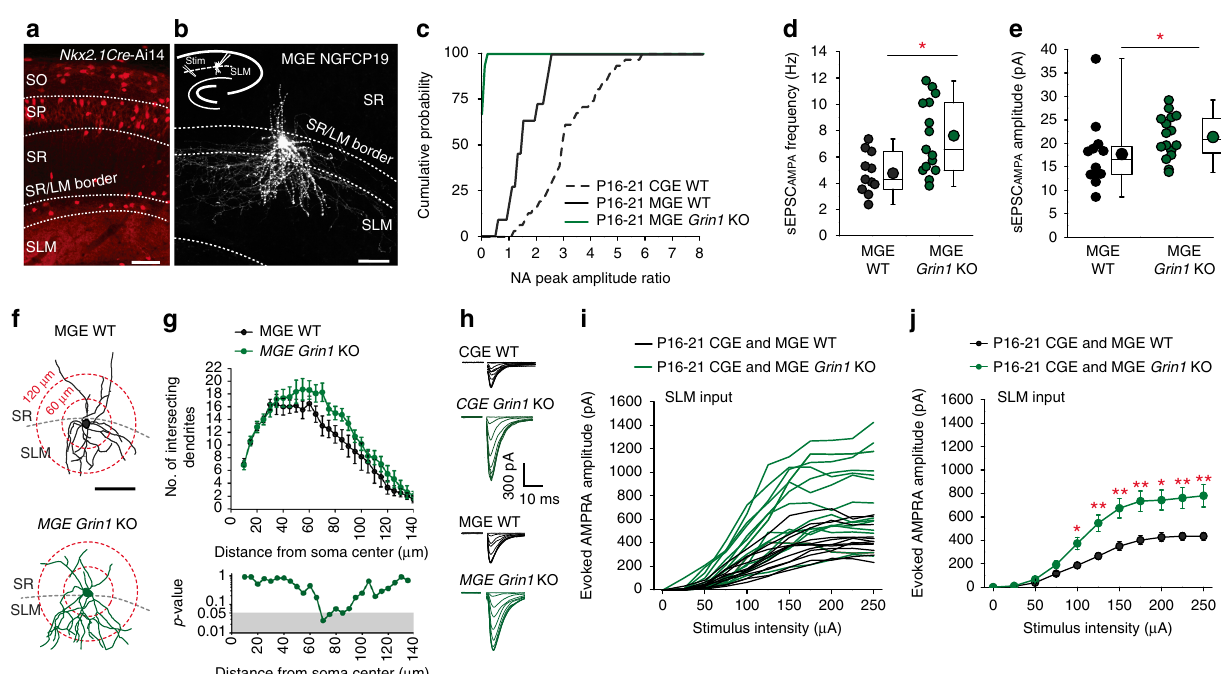
Fig. 5 NMDA-hypofunction precipitates similar morpho-physiological abnormalities in MGE NGFCs resulting in increased synaptic strength of SLM excitatory drive regardless of embryonic origin. a Confocal image of Nkx2.1Cre:Ai14 mouse illustrating the lamina distribution of MGE-derived interneurons. Scale bar , 100 μ m. b Confocal image of a biocytin- fi lled TdTom-positive NGFC illustrating the polarized dendrites in SLM and SR. Scale bar , 50 μ m. Inset depicting recording and stimulus (stim) electrode arrangement. c Cumulative distribution of NA peak amplitude ratios in P16-21 MGE WT ( black line ; n = 12) and MGE Grin 1 KO ( green line ; n = 16) mice. Black dotted line denotes NA ratio distribution in CGE WT NGFCs at P16-21 and is re-plotted from Fig. 1k for comparative purposes. d sEPSC AMPA frequency in MGE NGFCs in P16-21 WT ( black circles ; n = 11) and Grin1 KO mice ( green circles ; n = 16). e sEPSC AMPA amplitude in MGE NGFCs in P16-21 WT ( black circles ; n = 11) and Grin1 KO mice ( green circles ; n = 16). f Dendritic arborization of MGE NGFCs from WT ( black cell ; top panel ) and Grin1 KO ( green cell ; bottom panel ) mice. Examples of concentric circles employed for Sholl analyses ( red circles ). Scale bar , 100 μ m. g Sholl analyses plots of NGFC dendrites from WT ( black data ; n = 6) and Grin1 KO mice ( green data ; n = 12). Bottom panel show statistical comparison with shaded gray areas denoting p < 0.05. h Single overlaid traces of SLM afferent evoked AMPAR-mediated EPSCs in CGE and MGE NGFCS from P16-21 WT ( black traces ) and Grin1 KO ( green traces ) mice at varying stimulus strengths (0 – 250 μ A in 25 μ A steps). i , j Individual and pooled relationship of SLM- evoked AMPAR-mediated EPSC amplitude vs. stimulus strength. Data of P16-21 CGE and MGE NGFCs from WT ( black data ; n = 7 and 6, respectively) and Grin1 KO ( green data ; n = 8 and 7, respectively) mice are combined. SO stratum oriens, SLM stratum laconosum molecular, SP stratum pyramidale, SR stratum radiatum, Mann – Whitney U -tests were used for all comparisons (* p < 0.05, ** p < 0.01). Construction of box-whisker plots is detailed in methods. All n values correspond to the number of cells recorded. Error bars denote